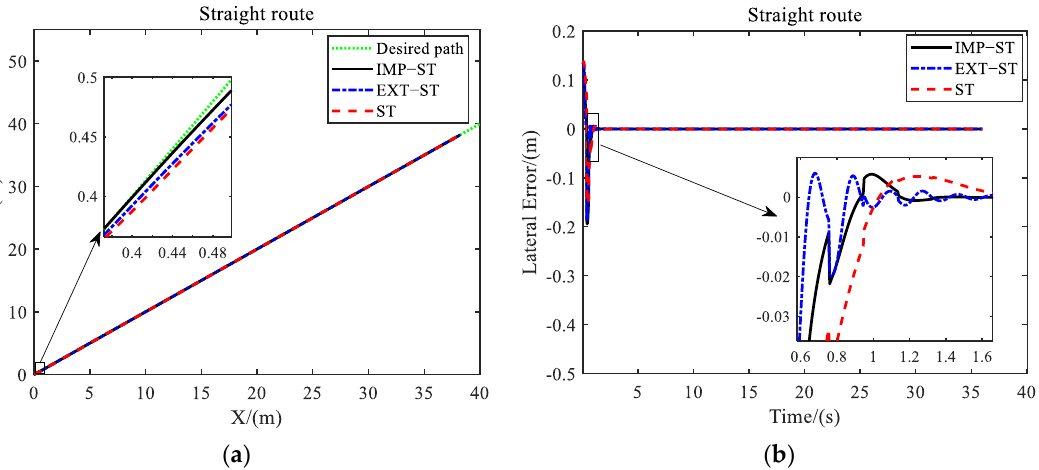
Figure 8. Path tracking performance comparison of three controllers for a straight route. ( a ) trajectory; ( b ) lateral error.